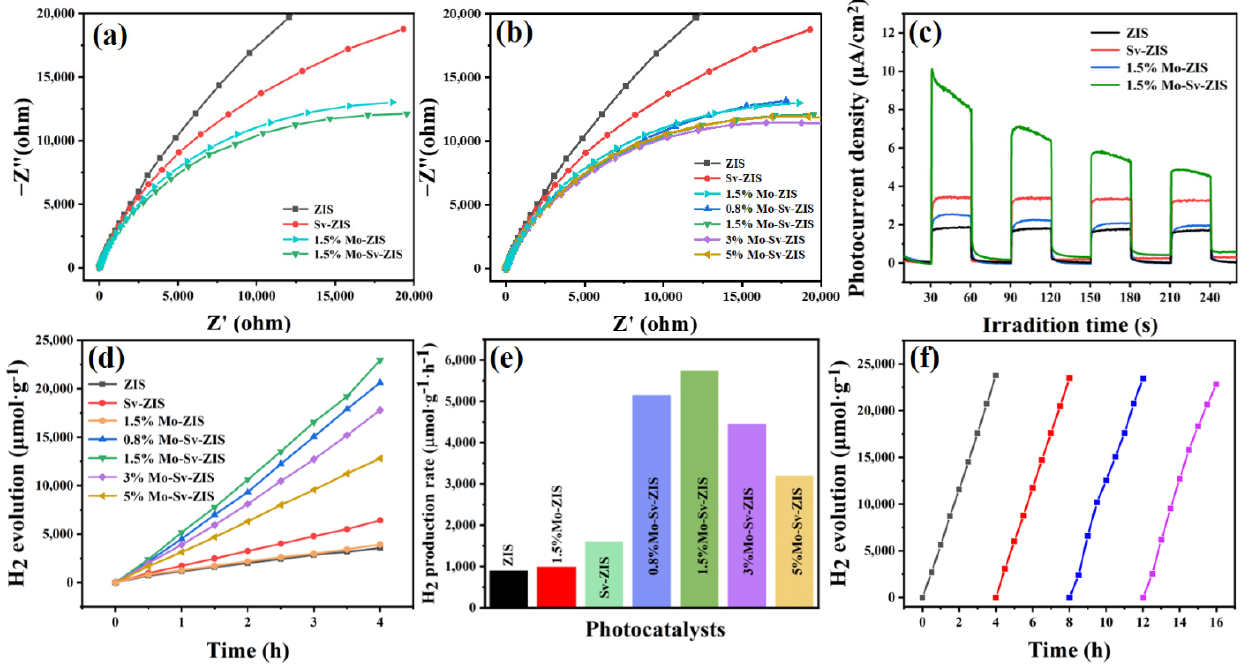
Figure 6. ( a ) The Nyquist plot displays the EIS of ZIS, Sv-ZIS, 1.5% Mo-ZIS and 1.5% Mo-Sv-ZIS. ( b ) EIS of all the samples. ( c ) Transient photocurrent responses of ZIS, Sv-ZIS, 1.5% Mo-ZIS and 1.5% Mo-Sv-ZIS electrodes under visible-light irradiation. ( d ) Time-dependent hydrogen evolution by photocatalysis in visible irradiation (>420 nm). ( e ) Photocatalytic H 2 evolution rates of ZIS, Sv-ZIS, 1.5% Mo-ZIS and Mo-Sv-ZIS with different Mo contents. ( f ) Hydrogen evolution cycle 16 h test on 1.5% Mo-Sv-ZIS.